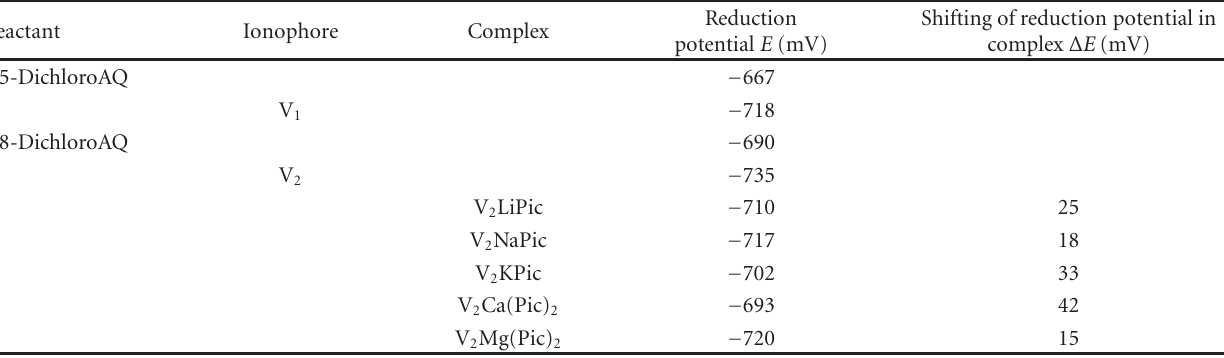
Table 4: Cyclic voltammetric data of redox switched ionophores and their complexes.